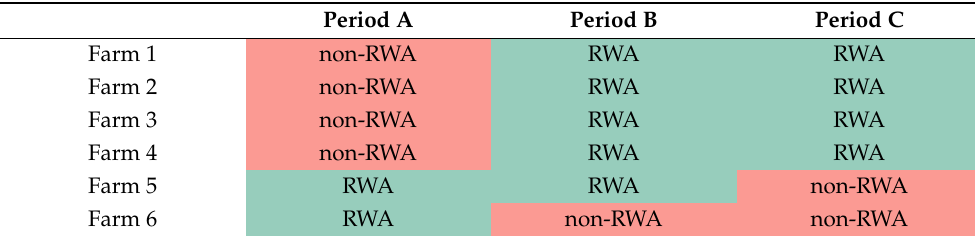
Table 2. The status of the farms—i.e., (non-)RWA—could vary over time. For most farms, the status remained the same during the entire study. However, on six farms, the status varied in the different periods of the study (A, B, and